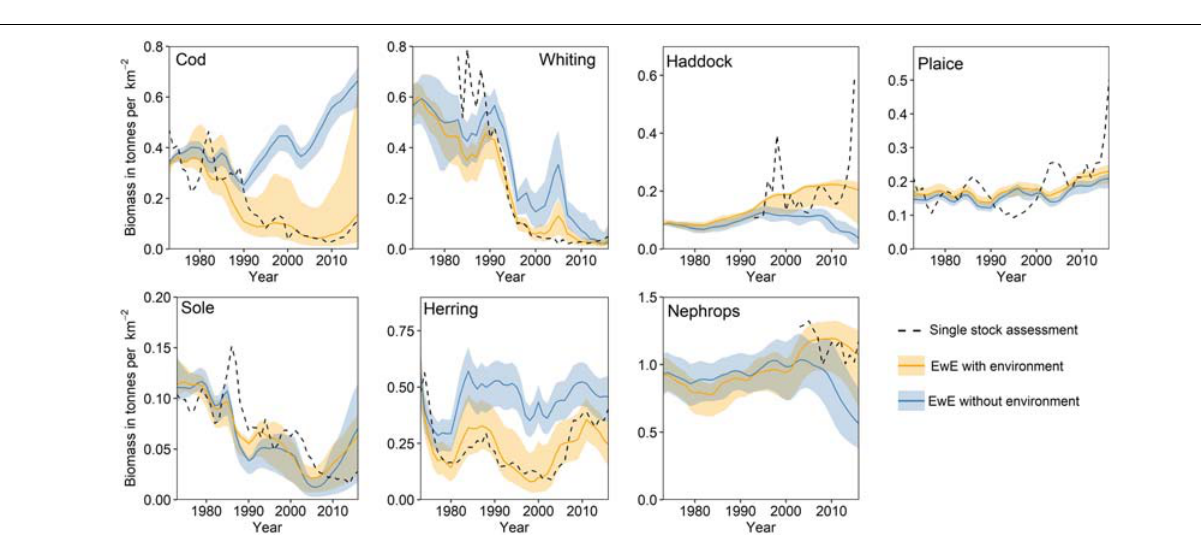
FIGURE 3 | Biomass simulations for commercial stocks in the Irish Sea. Simulations were generated using the Irish Sea EwE key run (ICES, 2019c) with environmental drivers (orange) and without environmental drivers (blue) to discern the role of environmental change in stock trajectories. Solid lines indicate baseline model simulations and shaded areas indicate 95% confidence intervals based on input uncertainty (see Bentley et al., 2020). Dashed lines indicate biomass trends from single-stock assessment